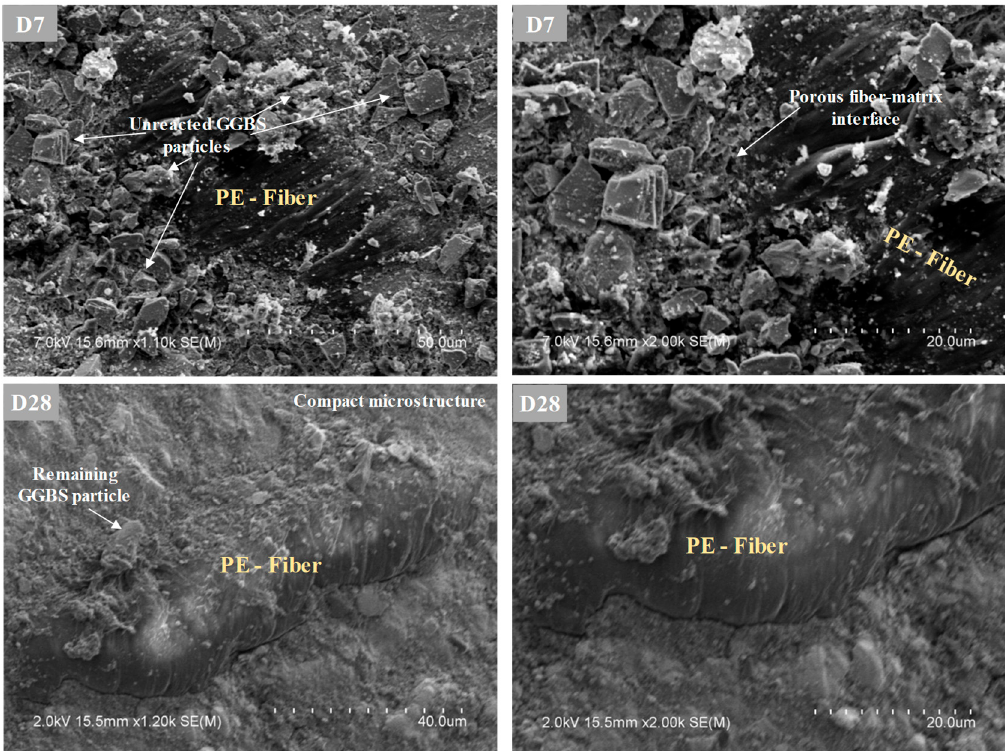
Figure 6. SEM images on the microstructure of specimens D7 and D28.